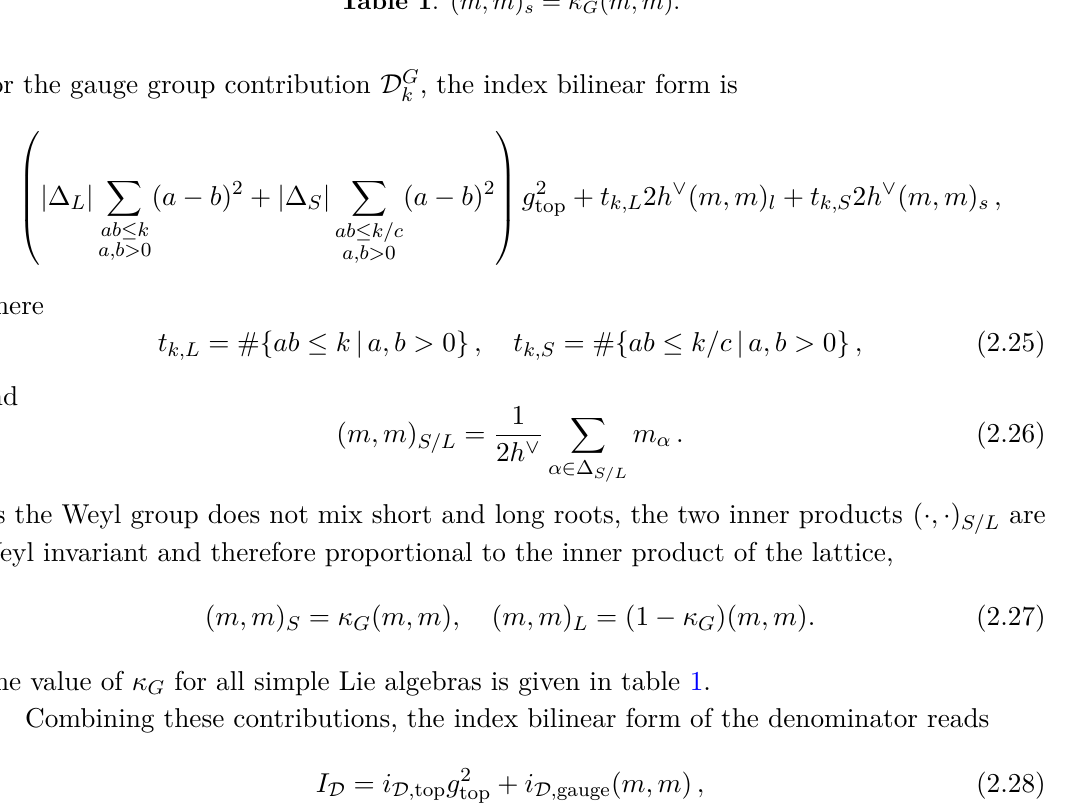
Table 1 . ( m, m ) s = κ G ( m, m )